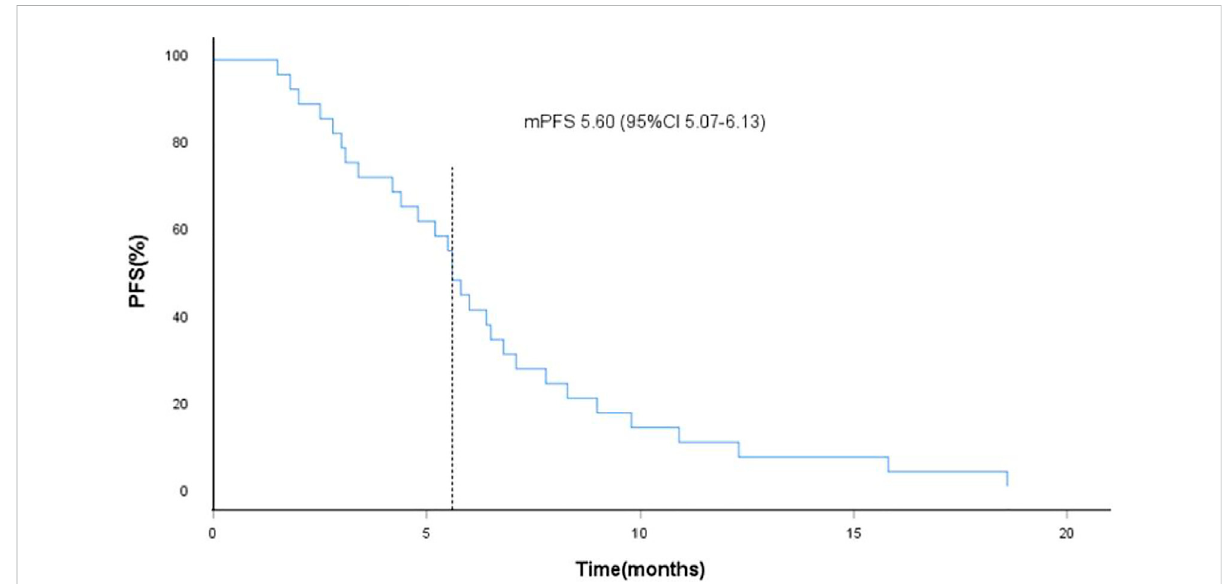
FIGURE 2 Kaplan-Meier curves of progression-free survival (PFS), the dotted line indicated the median PFS, which is 5.60 months analyzed by Kaplan- Meier method.